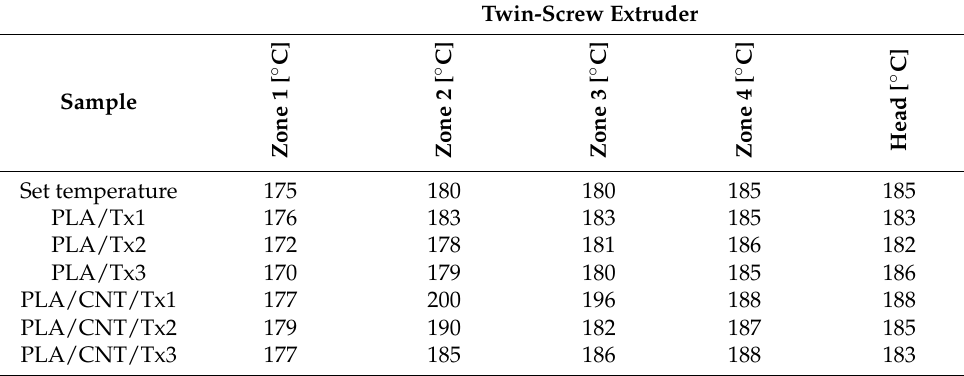
Table 5. Set and extrusion temperature—twin-screw